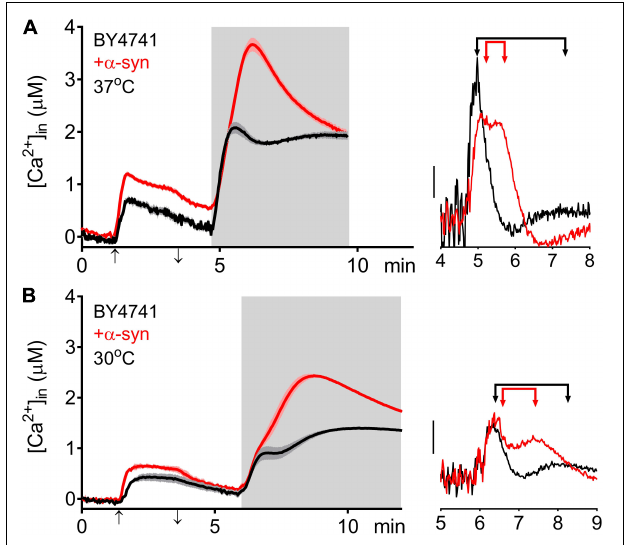
FIGURE 4 | α -Syn overexpression in BY4741 cells. Averaged Ca 2 + transient ± SEM (thin lines either side of the Ca 2 + transient trajectory) of BY4741 (black traces) and BY4741 overexpressing α -syn (+ α -syn – red traces) at 37 (A) and 30 ◦ C (B) . Cells were initially perfused with Ca 2 + -free starvation medium and then transferred to a 10 mM external Ca 2 + medium for 2 min (indicated by up and down arrow on X -axis). Thereafter, cells were briefly exposed to Ca 2 + -free intracellular medium prior to membrane permeabilization using Triton X-100 (indicated by light gray zone). Right insets : first derivative of the Ca 2 + release transients versus time showing fast and slow release components (indicated by arrowed bars). Scale bar corresponds to 1 µ M/min.